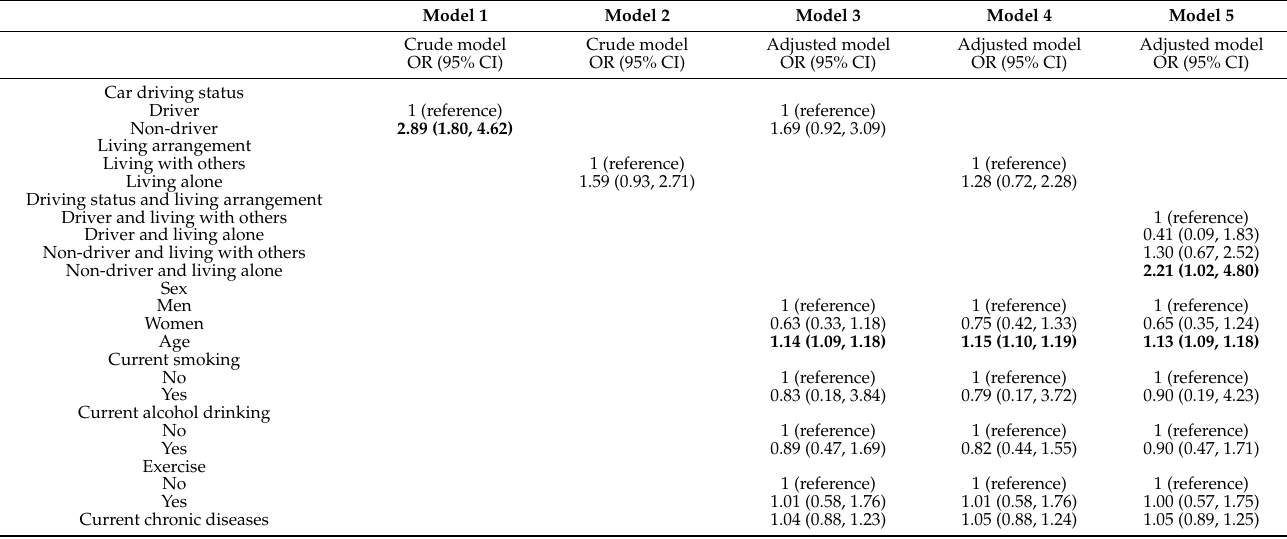
Table 2. Associations of car driving status and living arrangement with sarcopenia among community- dwelling older